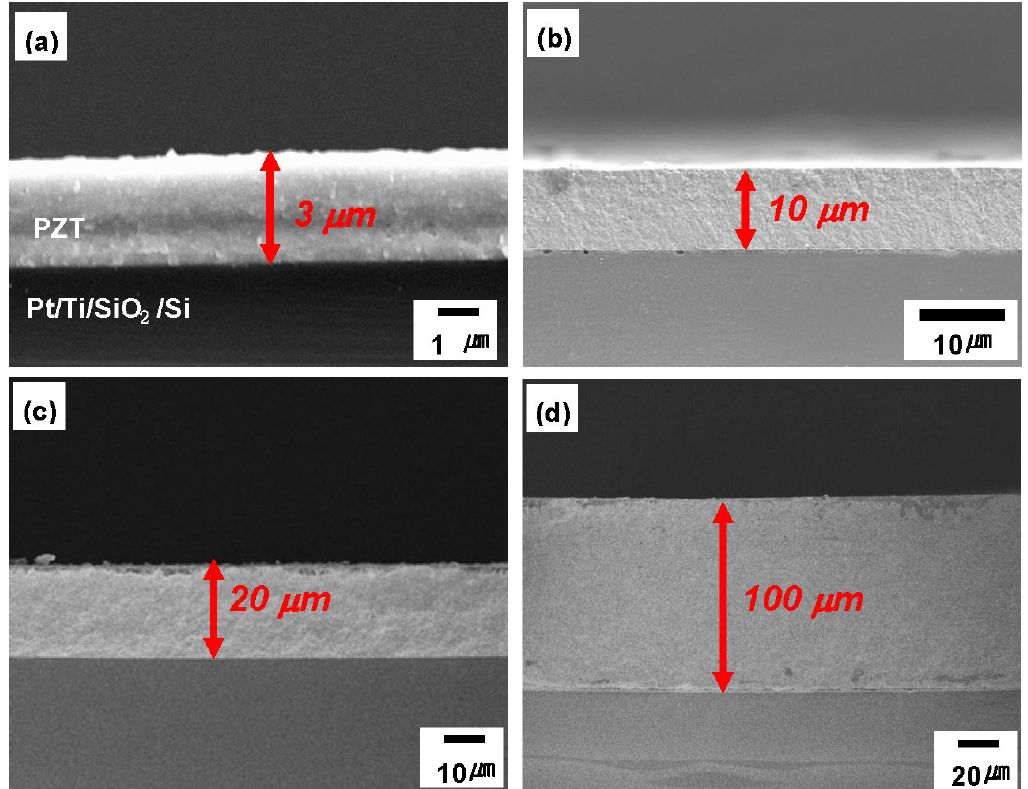
Figure 10. Cross-sectional view of piezoelectric film with various thickness by AD;